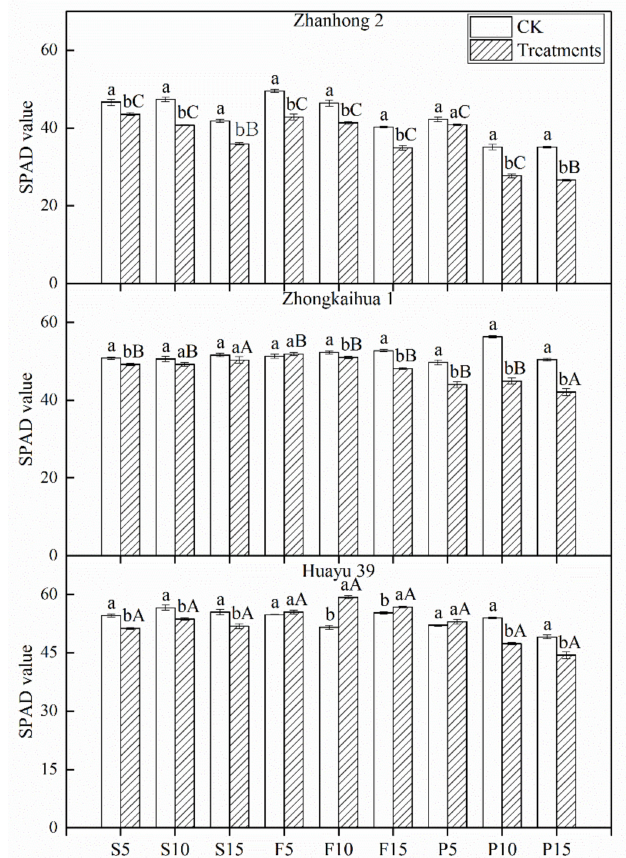
Figure 5. Effects of waterlogging stress on the SPAD value in three peanut ecotypes at different growth stages. Data are presented as the average value ( n = 3). Different lowercase letters indicate statistically significant differences between treatments ( p < 0.05) in the same ecotype, as determined by the least significant difference test. A, B, C indicate statistically significant differences between the different ecotypes under the same waterlogging stress treatments ( p < 0.05), as determined by the least significant difference test. S5, S10, S15, F5, F10, F15, P5, P10, P15 indicate the waterlogging stress for 5, 10, and 15 days at the seedling, flowering, and pod-filling stages, respectively; CK: control (plants without waterlogging stress); treatments: plants with waterlogging